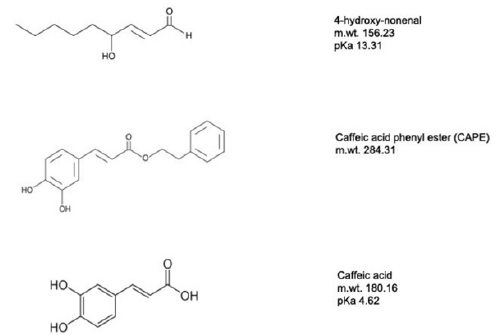
Figure 4. The molecular structures of 4-Hydroxynon-2-enal (4-HNE), caffeic acid phenyl ester and caffeic acid. Adapted from Reference [60].